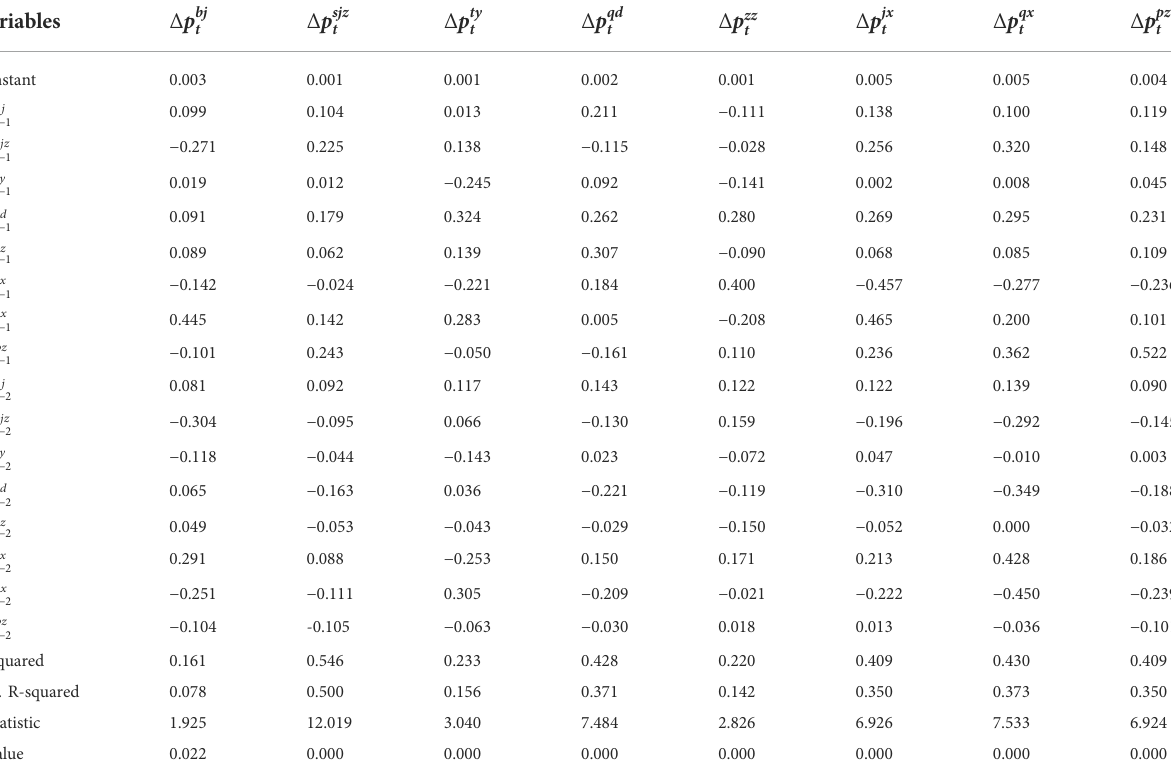
TABLE 4 Results of VAR model.